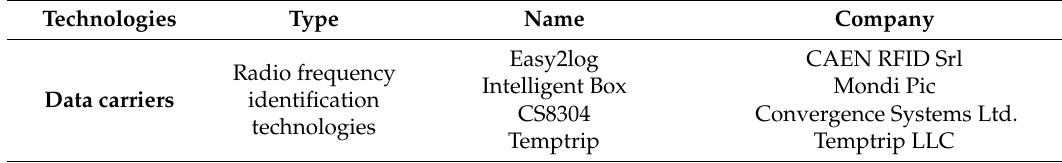
Table 3. Types of commercially available intelligent packaging